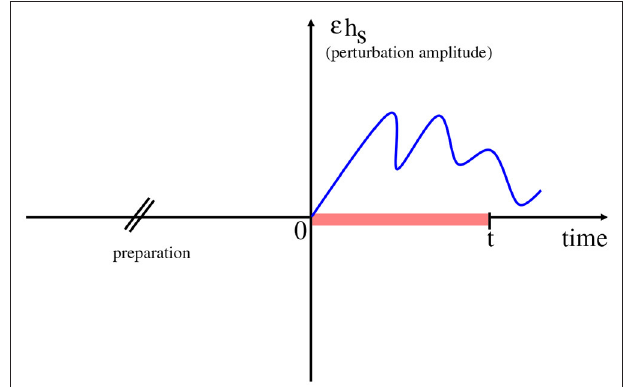
FIGURE 4 | The setup of response theory. Response is monitored at times [0, t ] from a stimulus in that same time-window and depending on the initial preparation (before time zero). The (small) amplitude of the perturbation may vary in